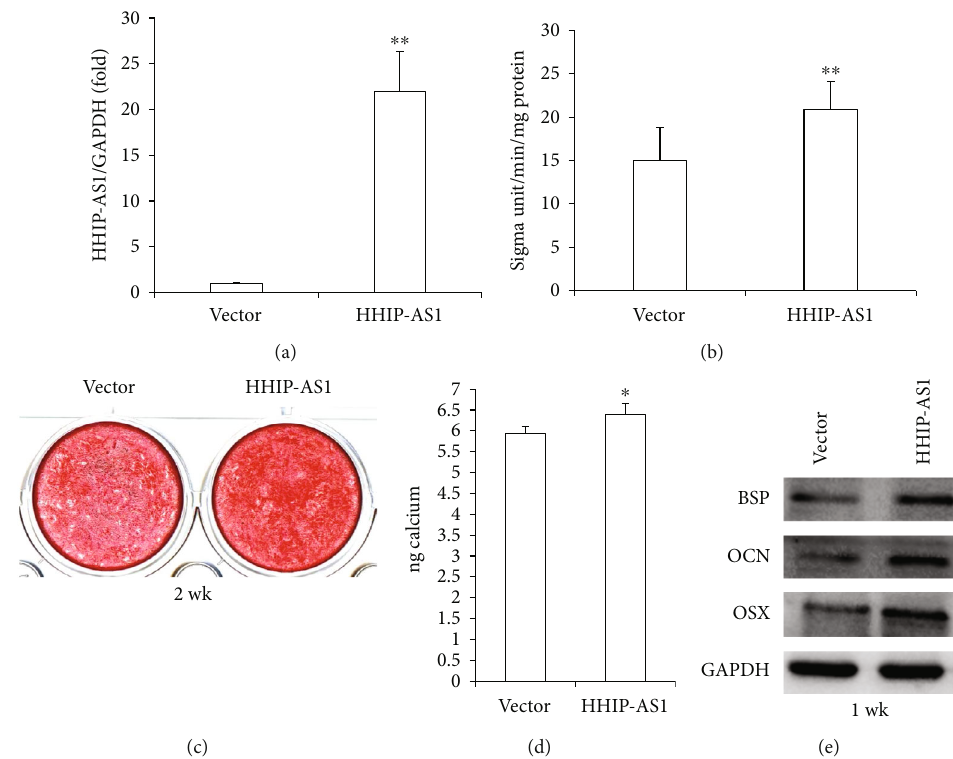
Figure 2: HHIP-AS1 overexpression promoted the osteogenic di ff erentiation potential of PDLSCs. (a) Real-time RT-PCR result showed the overexpression e ffi ciency of HHIP-AS1 in PDLSCs. (b) ALP activity after 5 days of osteogenic induction. (c) Alizarin Red staining result after 2 weeks of osteogenic induction. (d) Calcium quantitative analysis. (e) Western blot results displayed expressions of BSP, OCN, and OSX after 1 week of osteogenic induction. GAPDH was used as internal control in real-time RT-PCR and Western blot. Student ’ s t -test was performed to determine statistical signi fi cance. All error bars represent the SD ( n = 3 ). ∗ P ≤ 0 : 05 ; ∗∗ P ≤ 0 : 01